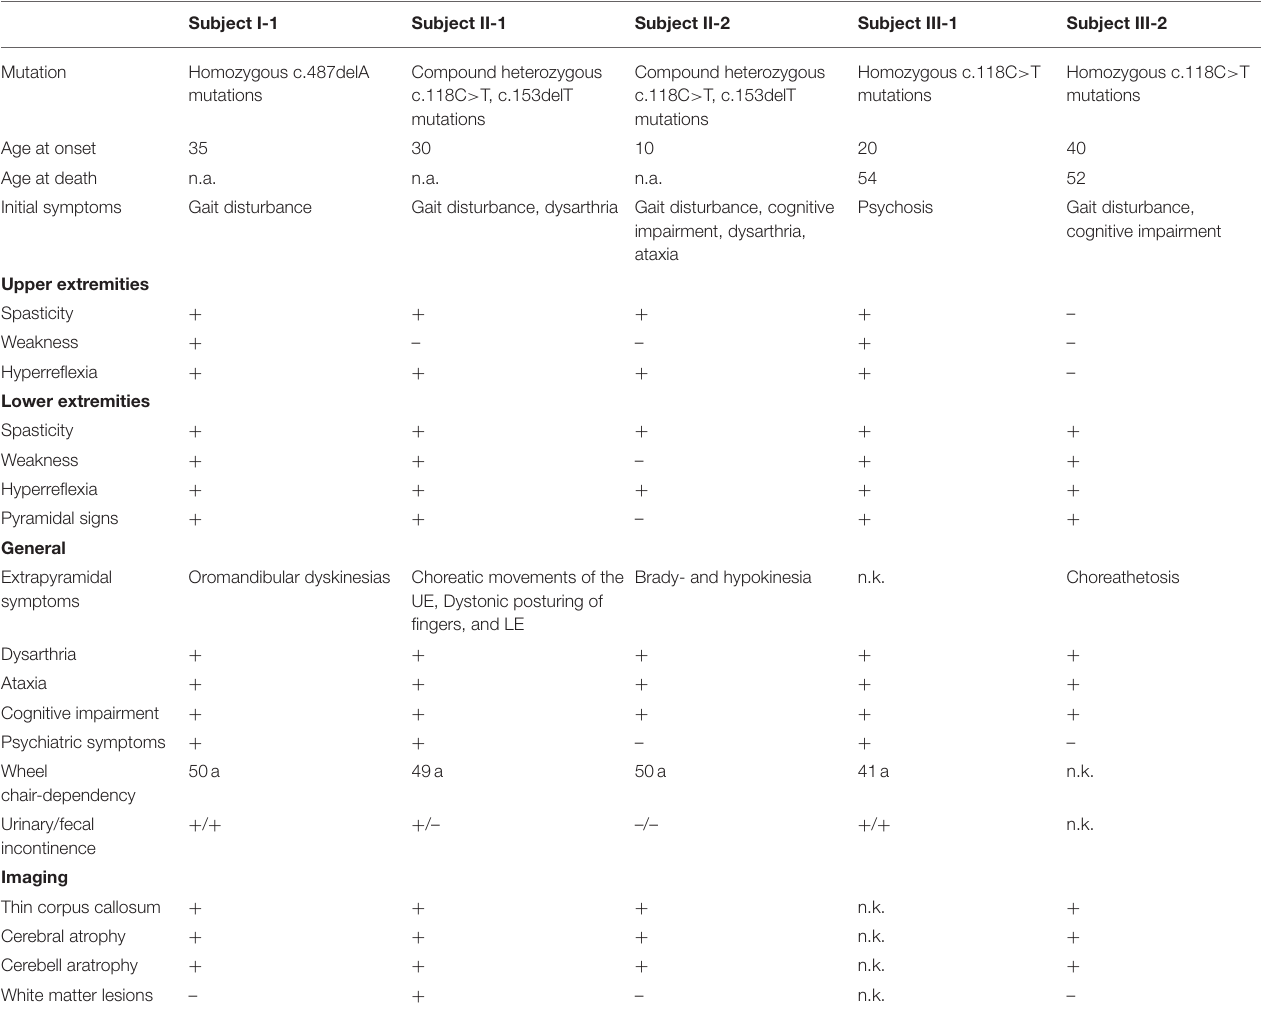
TABLE 1 | Demographics and clinical characteristics of the patients with SPG21